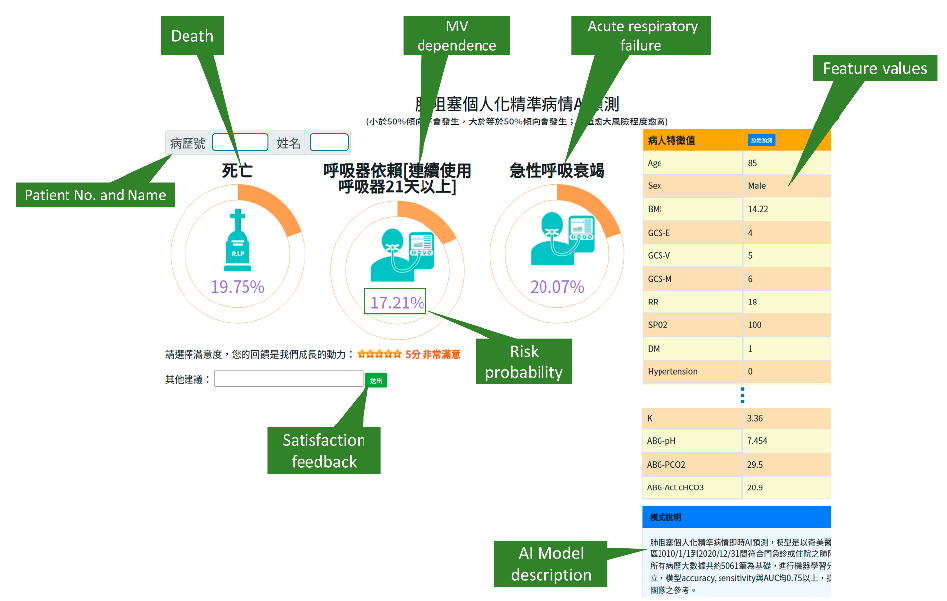
Figure 9. A snapshot of AI web service application for predicting outcomes of in-hospital COPD patients.